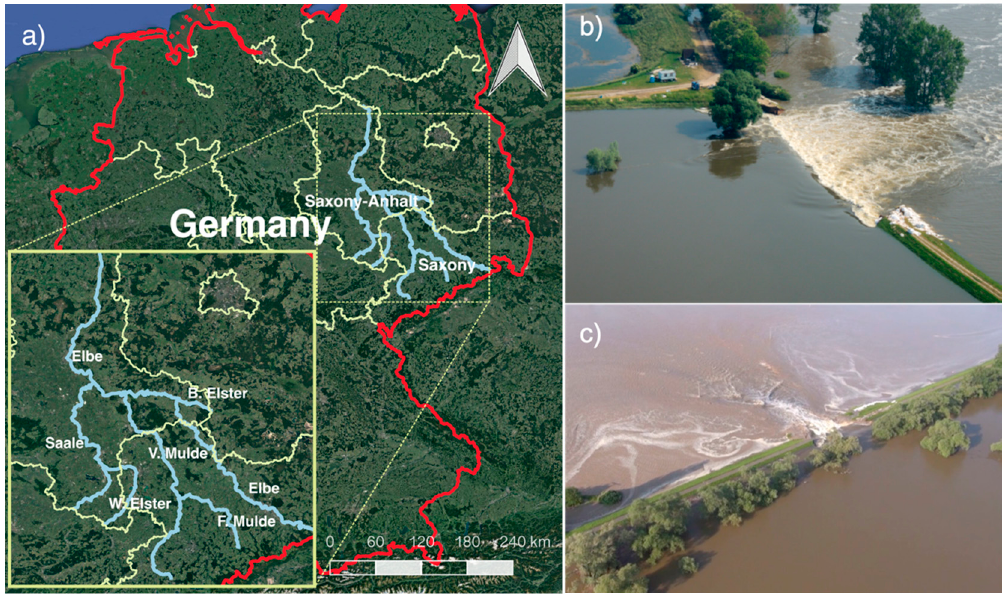
Figure 8. ( a ) Investigated rivers along the Elbe tributaries in Germany, which flooded in 2002 and 2013, ( b ) Fischbeck, 2013 (source: [42]), ( c ) Breitenhagen, 2013 (source: [43]). ( b ) Fischbeck, 2013 (source: [42]), ( c ) Breitenhagen, 2013 (source: